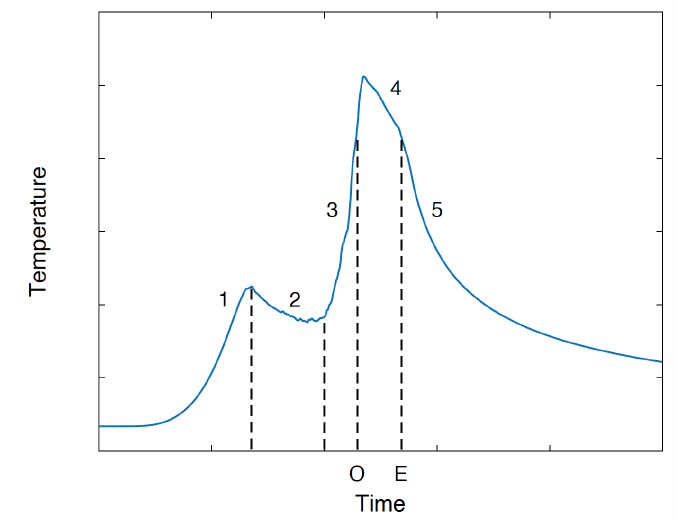
Figure 10. Thermal history of Inconel 718 on the dry drilled hole surface.